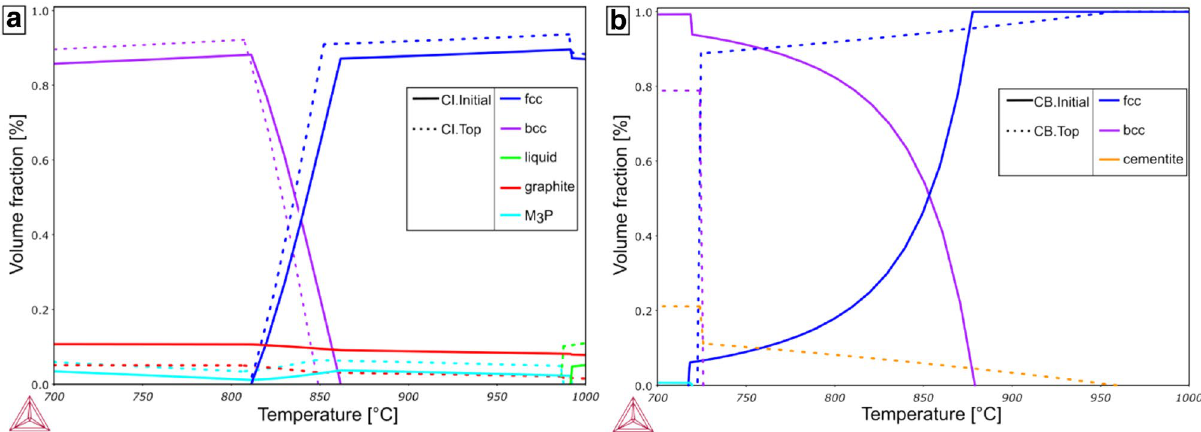
Fig. 7 Volume fraction diagram for the cast iron ( a ) and collector bar ( b ) in its initial condition (solid lines) and in “end of service”-condition (dotted